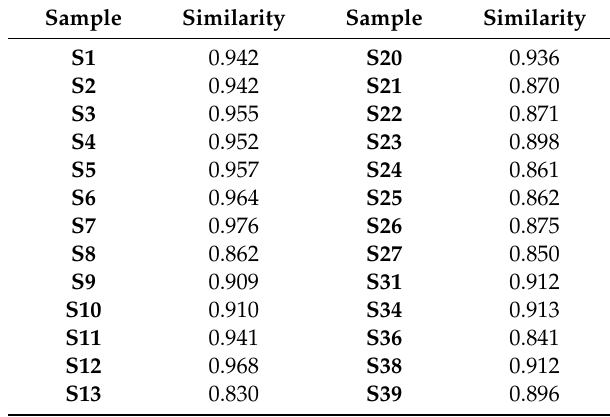
Figure 2. SFC fingerprints of different M. bealei samples and its substitutes. Experimental condition: NH 2 (4.6 mm × 250 mm, 5 μ m); mobile phase: (A) sCO 2 ; (B) MeOH containing 0.4% ( v / v ) diethylamine and 8% ( v / v ) water; gradient: 015 min/18%–25% B, 15–20 min/25%–35% B. 20.1–25 min/18% B; injection volume: 5 μ L; flow rate: 3.0 mL/min; column temperature: 28 °C; backpressure: 140 bar; detection wavelength: 230 nm; samples: S1–S27, S31, S34, S36, S39–S41, S46–S47, S49. Table 1. SA results of 37 batches of M. bealei samples and its substitutes.